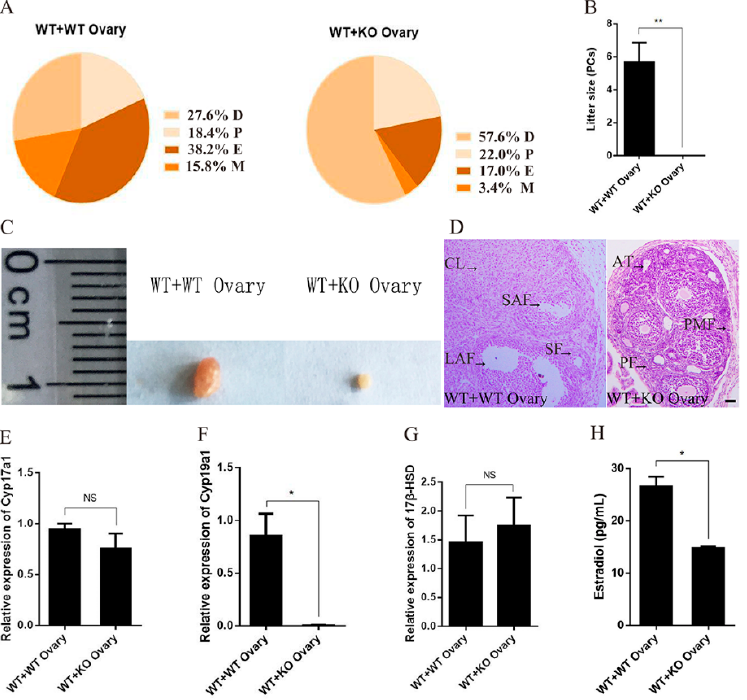
Figure 4. Deficiency of miR-7a2 in the ovary impairs ovarian function. ( A ) The estrus cycle of transplanted mice was determined by a vaginal smear for 18 consecutive days, comprising dioestrus, proestrus, estrus, and metestrus represented by D, P, E, and M, respectively; n = 6. ( B ) Ovary- transplanted mice were separately mated with WT male mice for three weeks, and the litter sizes were recorded; n = 6. ( C ) Macro-observation of ovaries from “WT + WT Ovary” mice and “WT + KO Ovary” mice. ( D ) Sections of ovary-transplanted mice were observed by H.E. staining; PMF: primodial